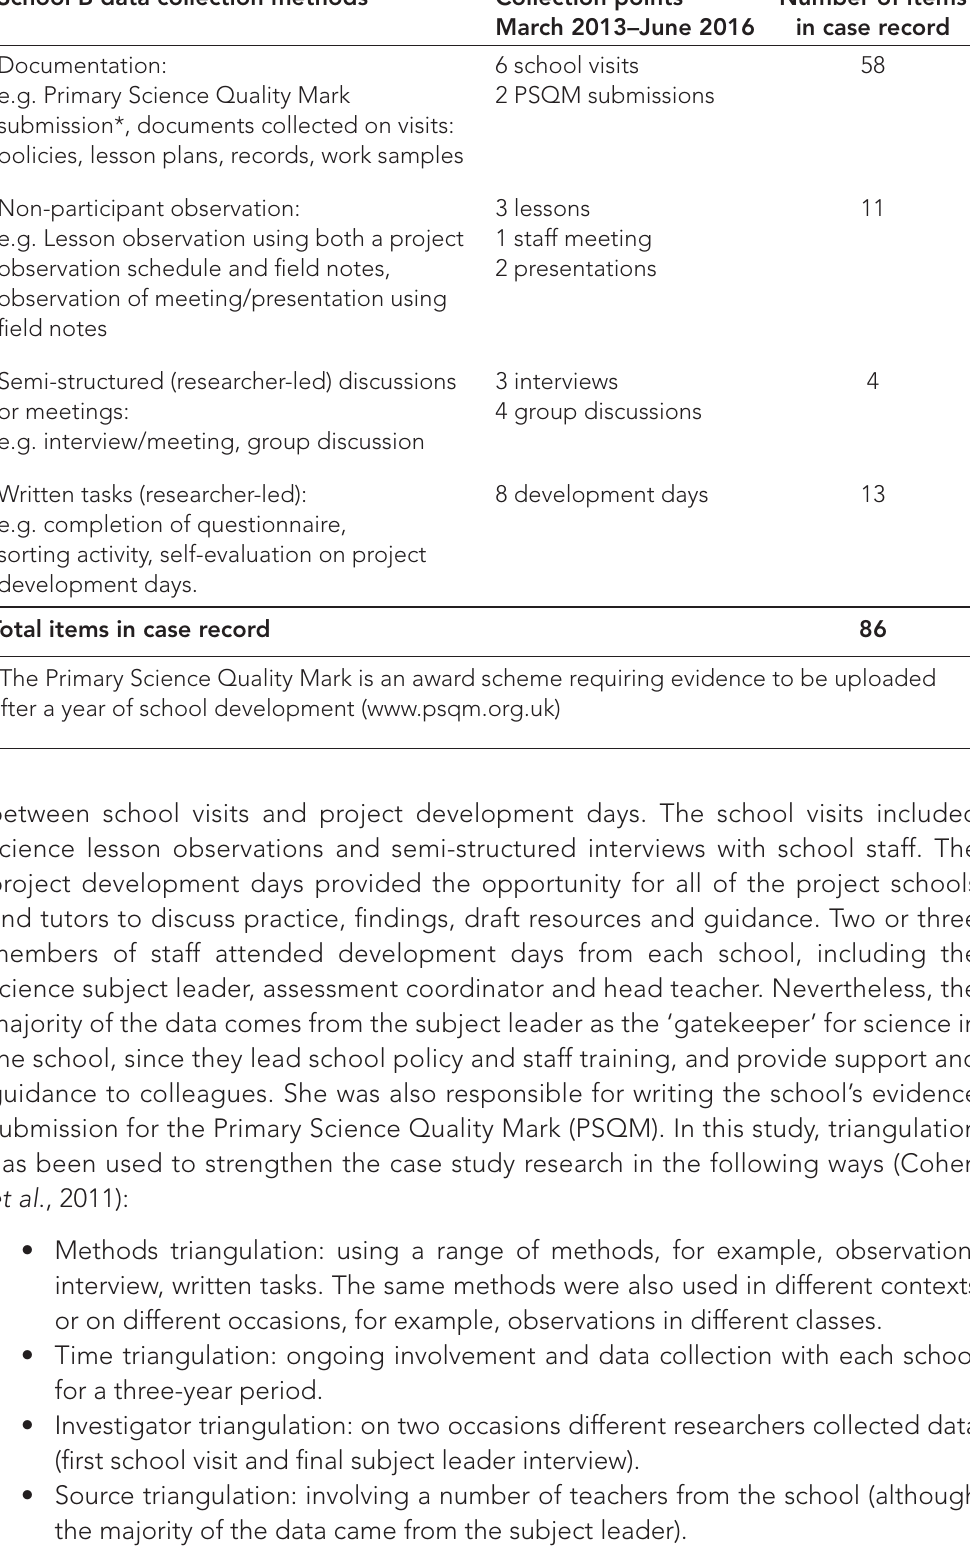
Table 1: Overview of data collection methods School B data collection